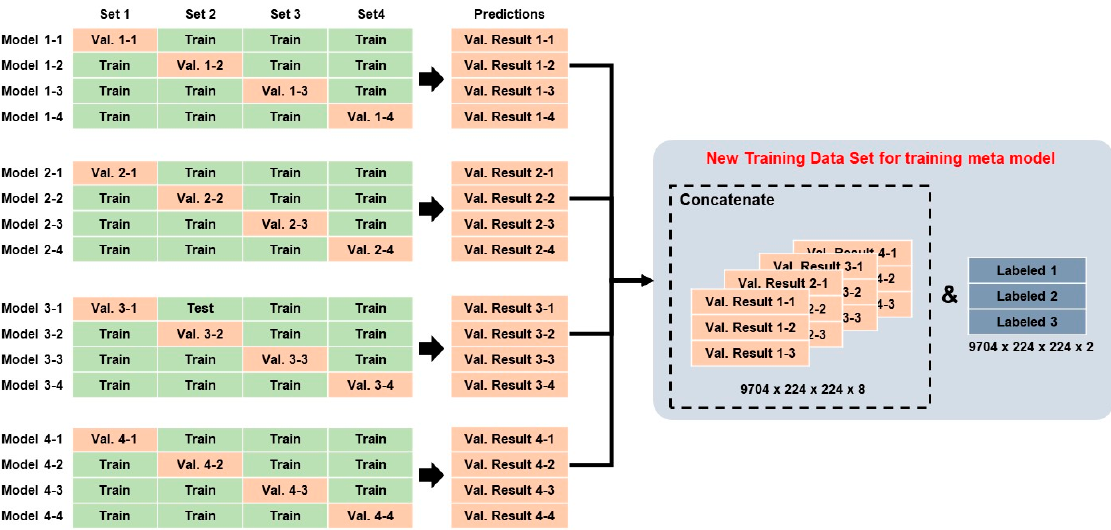
Figure 7. Metamodel architecture.